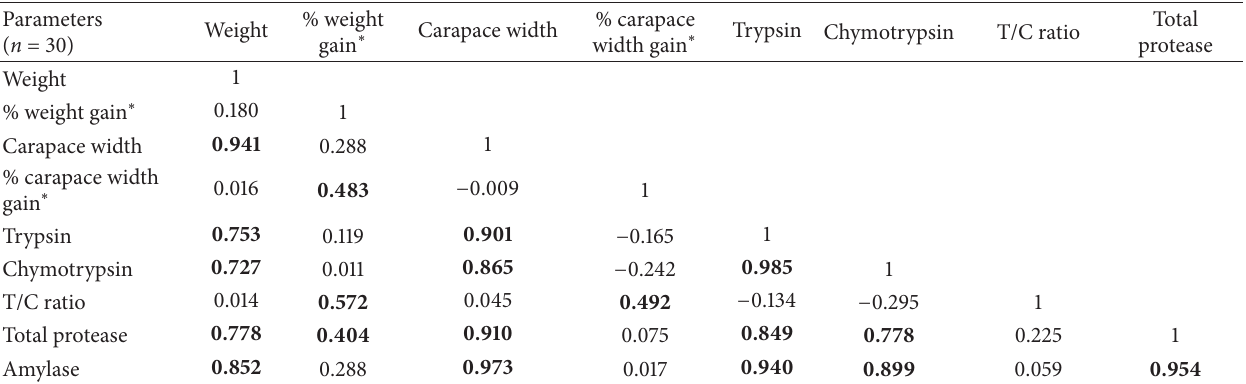
Table 4: Correlation coefficient ( r ) between different parameters studied during metamorphosis from zoea until adult P. pelagicus . Significant correlations are indicated in big bold numbers ( P < 0.05).